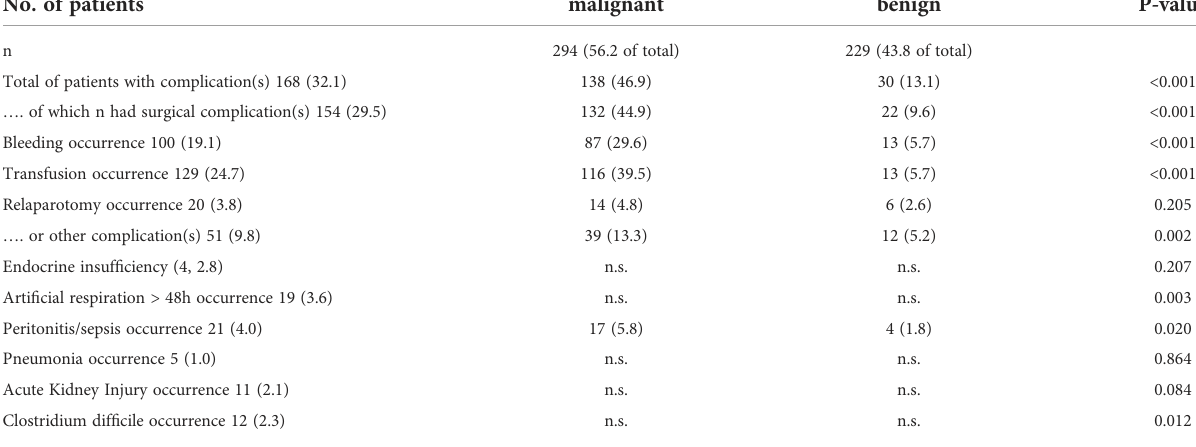
TABLE 4 Patients ≤ 21 years of age: complications.